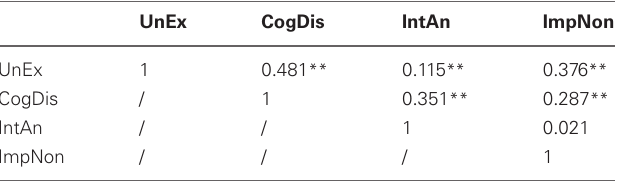
Table 3 | Inter-correlations of the O-LIFE scales.